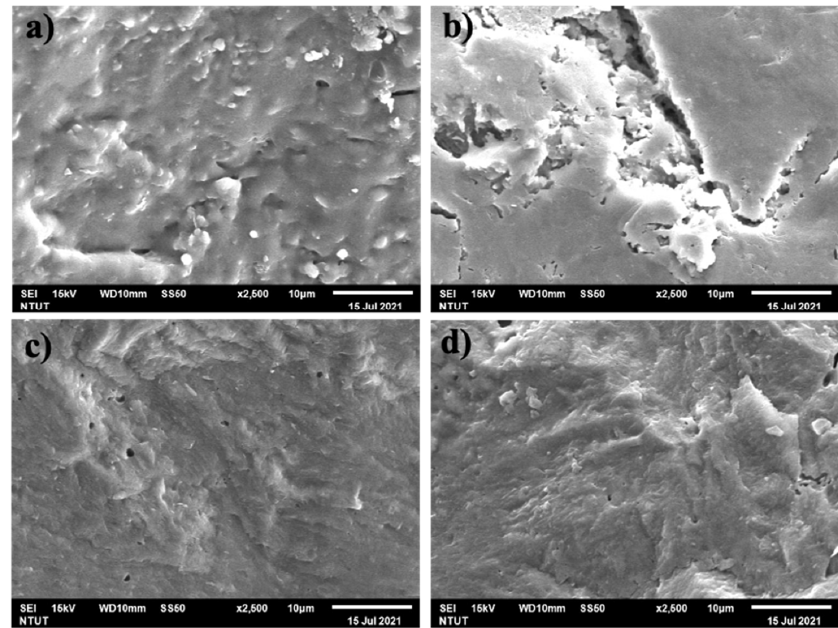
Figure 5. SEM images ( × 2500) of ( a ) T1, ( b ) T2, ( c ) T3, and ( d ) T4.